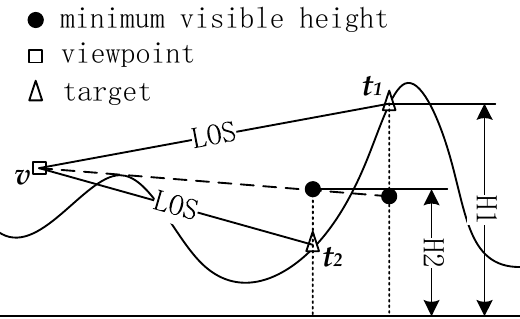
Figure 1. The direct LOS method and the LOS height. The curve represents the profile of a terrain. v is the viewpoint above the terrain. t 1 and t 2 are two adjacent targets on the terrain. The direct LOS method determines the visibility of a target point by comparing its predicted minimum visible height and its elevation. The elevation of t 1 is higher than its predicted minimum visible height. t 1 is visible and t 1 ’s LOS height H1 equals the actual elevation of t 1 . The elevation of t 2 is lower than its predicted minimum visible elevation. t 2 is invisible and its LOS height H2 equals the minimum visible height.